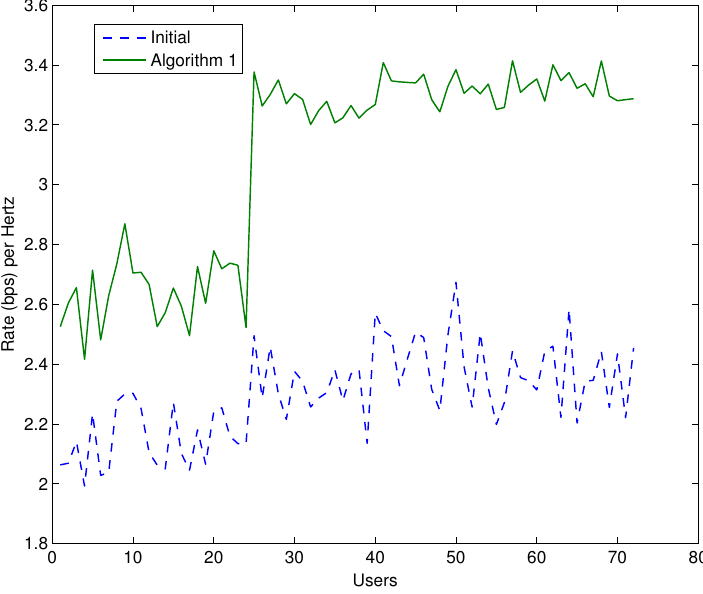
Figure 6. Rate per Hertz before and after the application of Algorithm